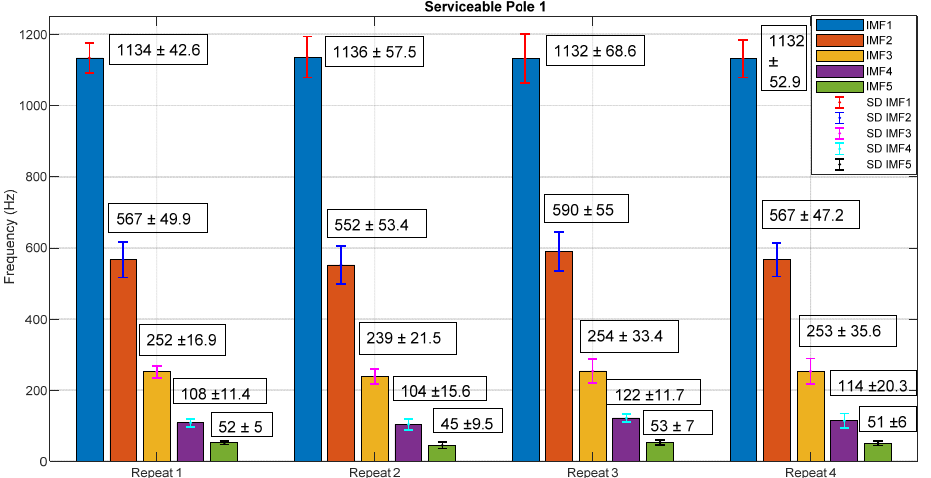
22 of 27 Figure 17. Hilbert spectrum of IMF1 for A90C1, Serviceable Pole 1 including all 4 tests. Additional significant finding here is that the improved HHT is able to recover low frequency and low energy components. Considering the signal up to 0.02 sec in Figure 16, it is observed that instantaneous frequency of IMF5 is almost constant at 55 Hz. This is the possible fundamental frequency/natural frequency of that particular pole. Similarly, 105 Hz and 250 Hz frequencies are observed for IMF4 and IMF3, respectively, which are be- lieved to be higher order fundamental frequencies. Since the condition of this pole is be- lieved to be healthy, there are not much sudden changes in the instantaneous frequency of IMF3, IMF4, and IMF5 and very slight changes are observed for IMF2. Similar analysis has been performed for 12 accelerometer data of 3 serviceable poles and 3 unserviceable poles obtained from all 4 tests in order to check the repeatability and consistency of the results. After that, frequency range of dominant IMFs, average frequency of each domi- nant IMF and standard deviation are calculated. Figures 18 and 19 demonstrate the fre- quency range of dominant IMFs, average frequency of each dominant IMF and standard deviation for Serviceable Pole 1 and Unserviceable Pole 3, respectively, considering all the